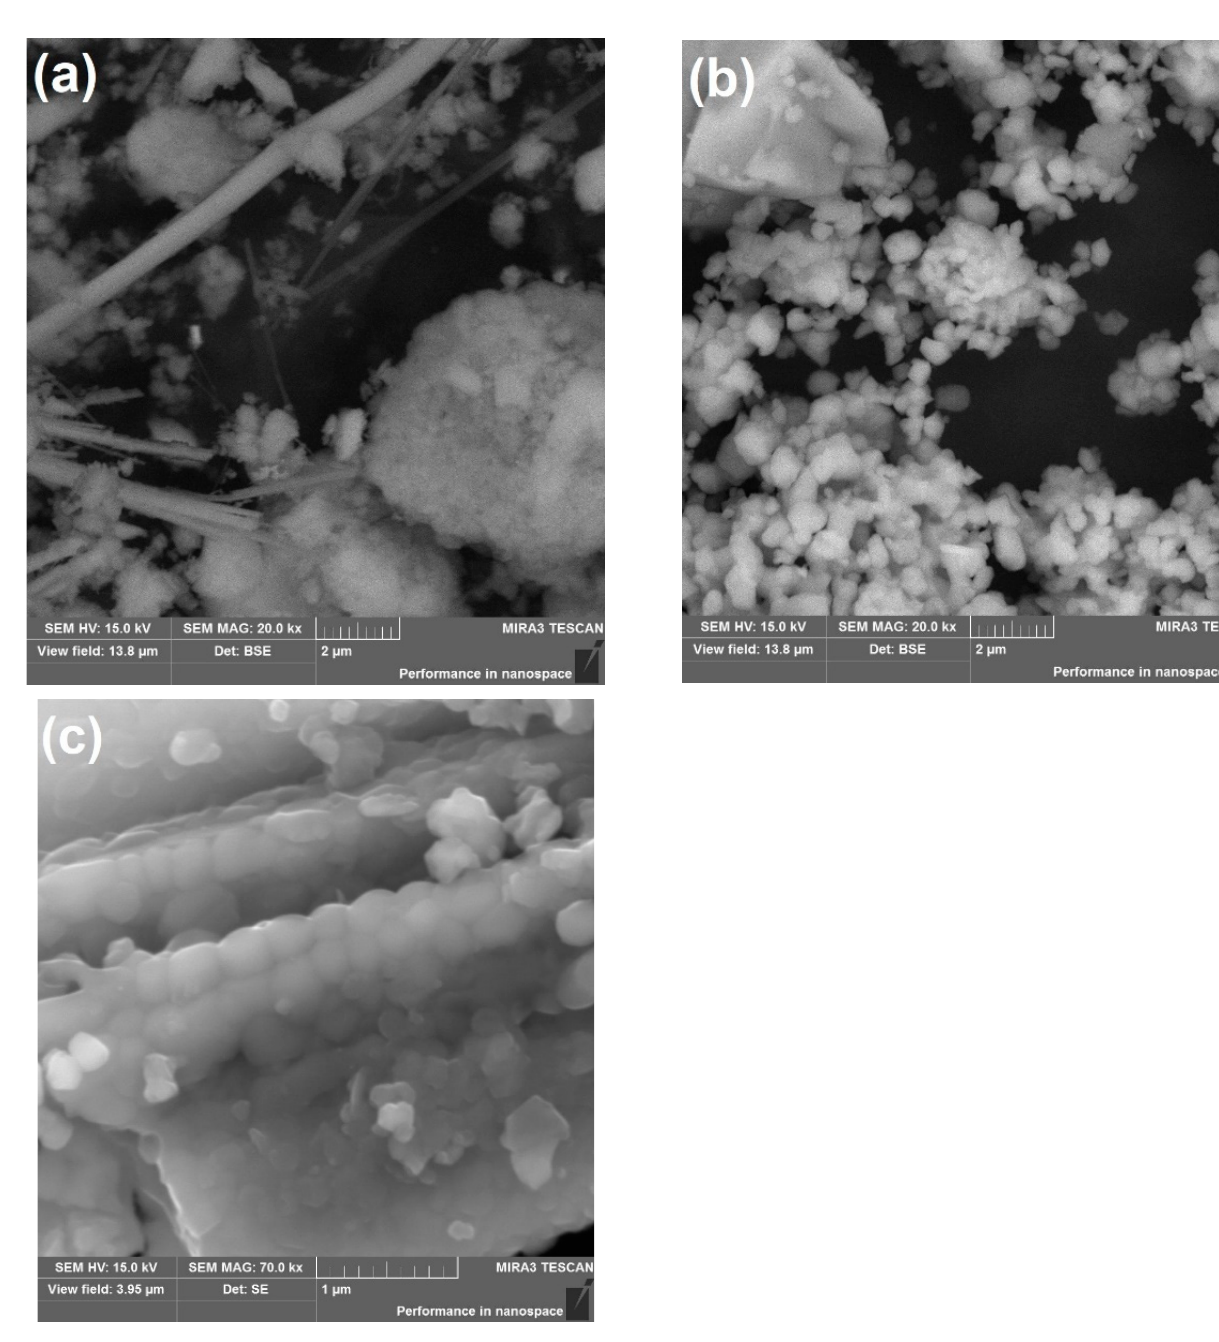
Figure 4. SEM image of AC sample: ( a ) raw, ( b ) calcined, ( c ) fiber pseudomorphs after calcination. The conducted calculations indicate that at a relatively low firing temperature, the liquid phase will be formed in sets C2 and A. In the case of D, E, and F, the liquid phase will appear during firing and sintering at a temperature of 1150–1300 ◦ C, with its highest amount recorded for set F. In the case of masses B and C, the liquid phase will appear the latest, according to the simulation, at a temperature of more than 1400 ◦